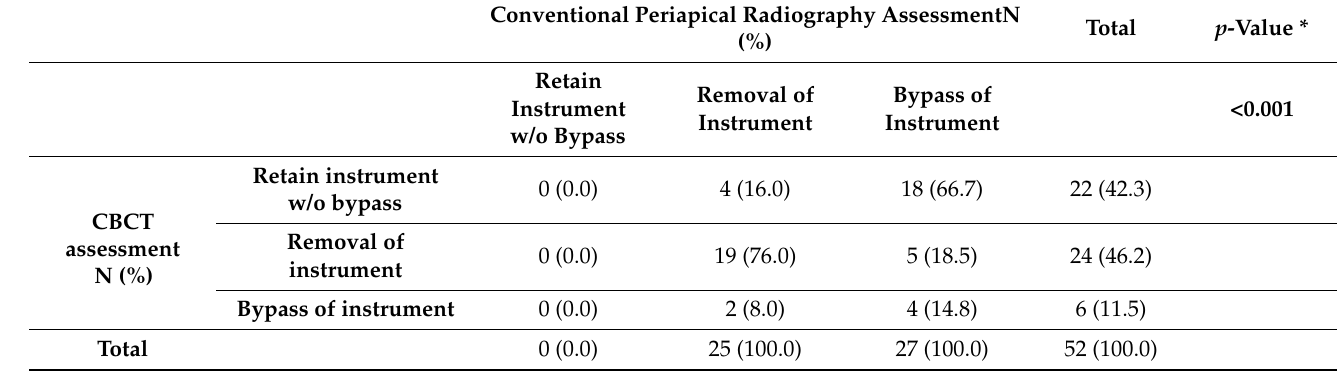
Table 2. Frequency distribution of treatment planning decisions, after classic radiographic assessment compared to evaluation of CBCT of the same cases ( n = 52